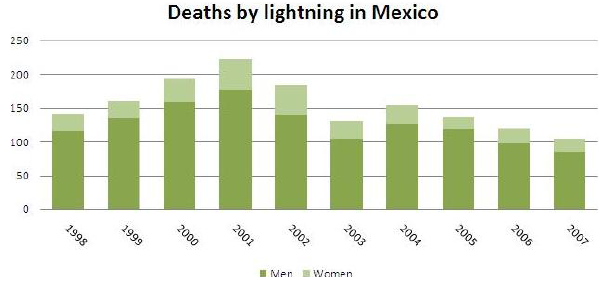
Fig. 1. Deaths by lightning occurred in Mexico between 1998 and